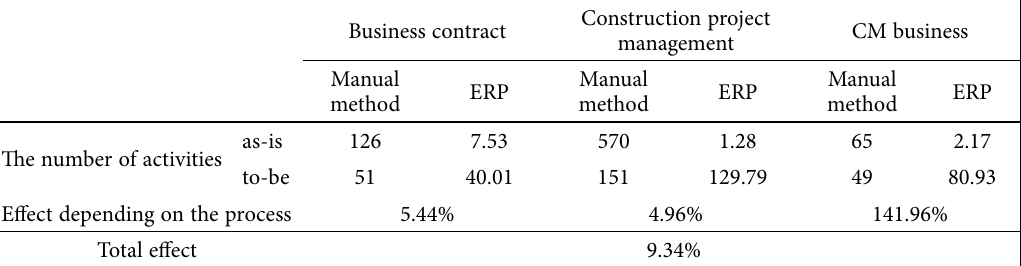
Table 7. Number of activities and effect depending on the process